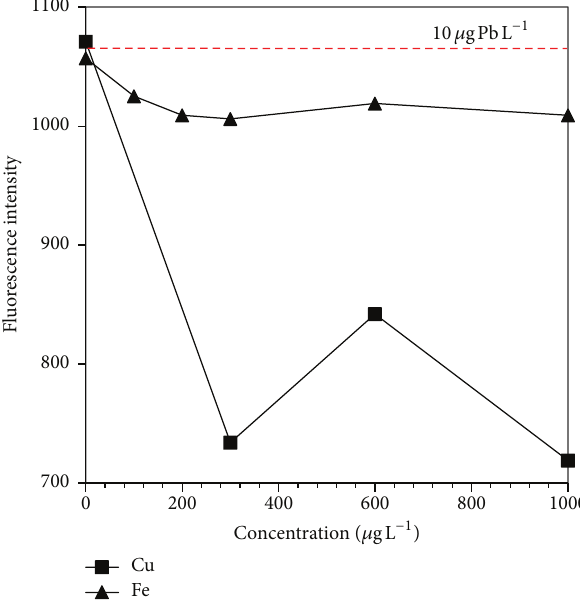
Figure 6: Effect of Cu and Fe concentrations on the fluorescence intensity of Pb. Peak height measurements for 10 𝜇 gPbL −1